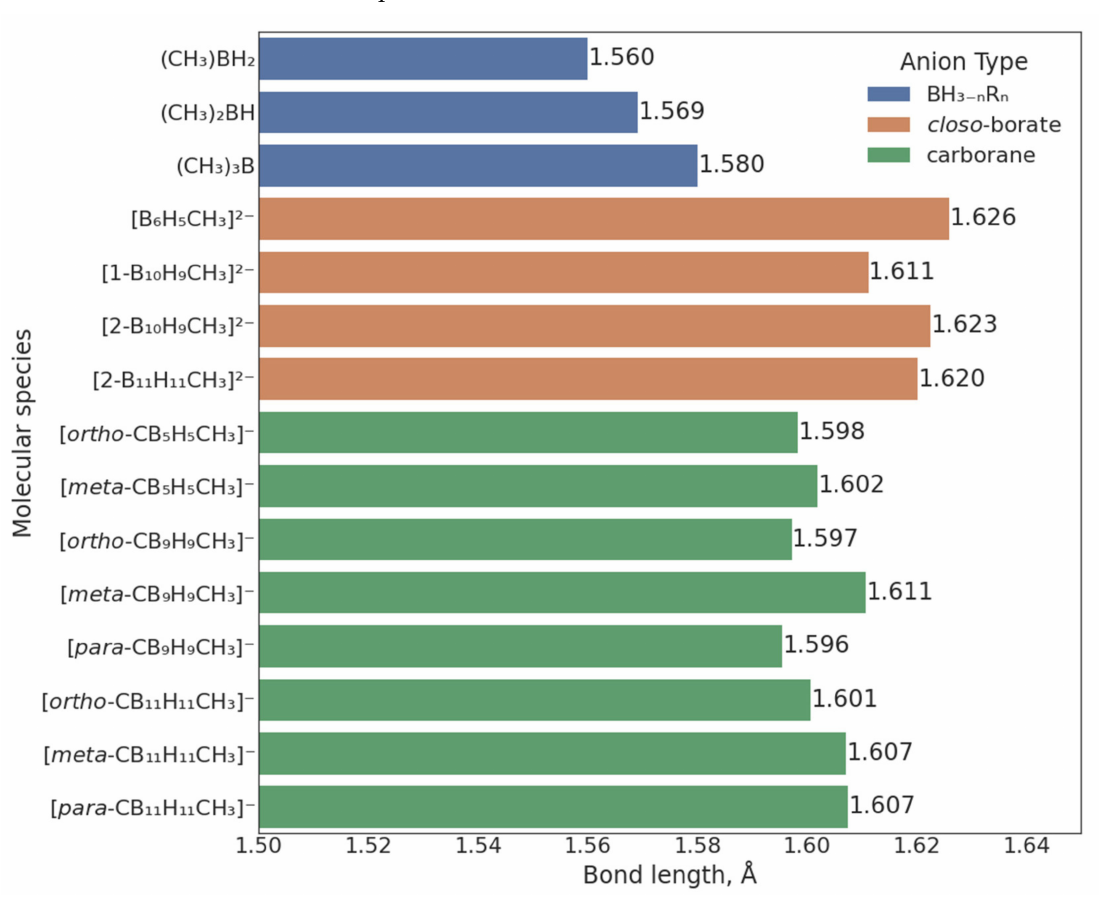
Figure 3. Values of B–C bond lengths in closo-borate anions of the general form [B n H n − 1 CH 3 ] 2 − (n = 6, 10, 12), monocarboranes [CB n H n CH 3 ] − (n = 5, 9, 11) and BH 3 − n (CH 3 ) n (n = 1–3). For monocarboranes, only exo -polyhedral B–C bonds were